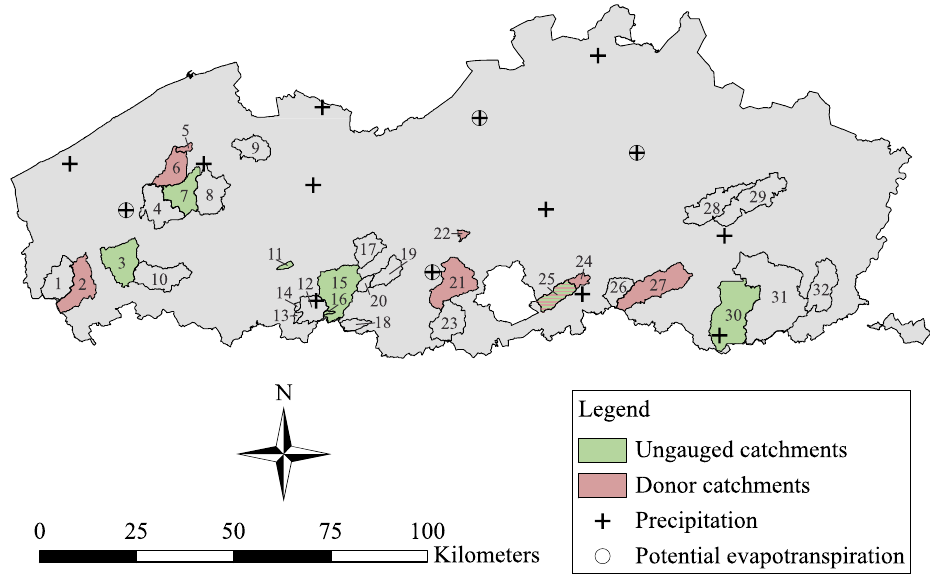
Fig. 2. The spatial spreading of the 32 catchments included in this study. The autochthonous catchments considered to be ungauged and the donor catchments are coloured green and red, respectively. Stations with precipitation and potential evapotranspiration measurement are indicated with crosses and circles,